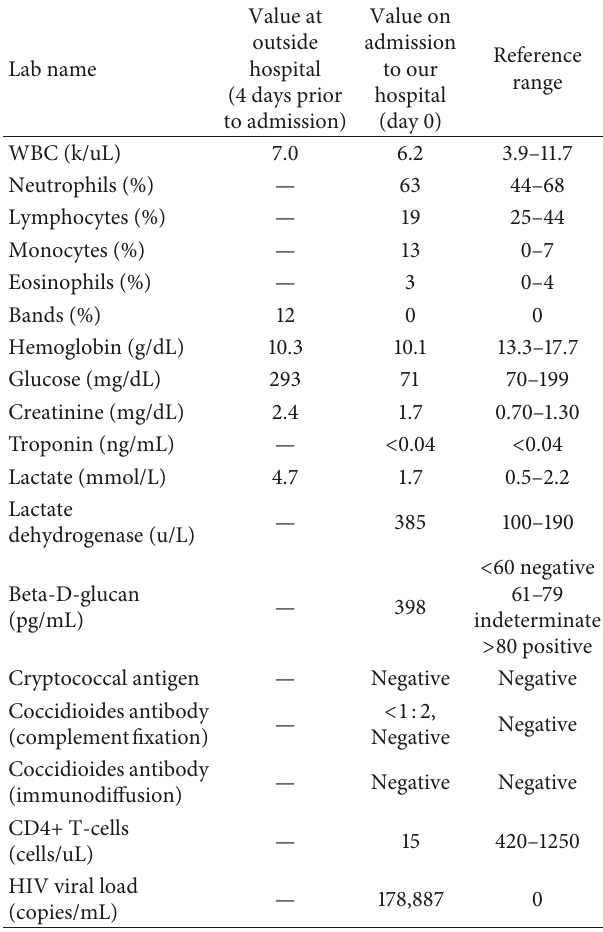
Table 1: Initial laboratory